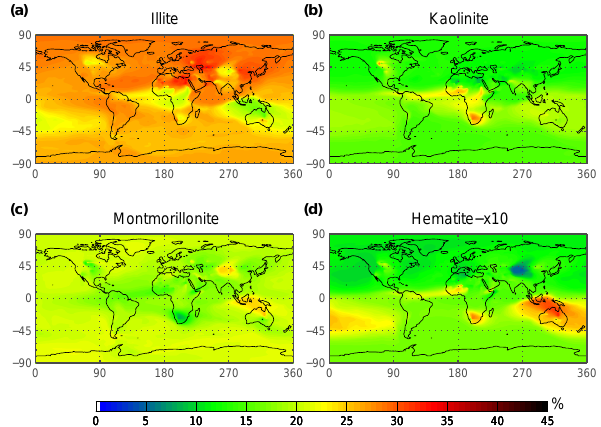
Figure 3. Total percent column mineral distributions for CAM5 shown as the sum of the fine mode (mode 1) and coarse mode (mode 3) for each mineral. Hematite (d) is scaled by 10 so that it can be visually compared with illite (a) , kaolinite (b) and mont- morillonite (c)